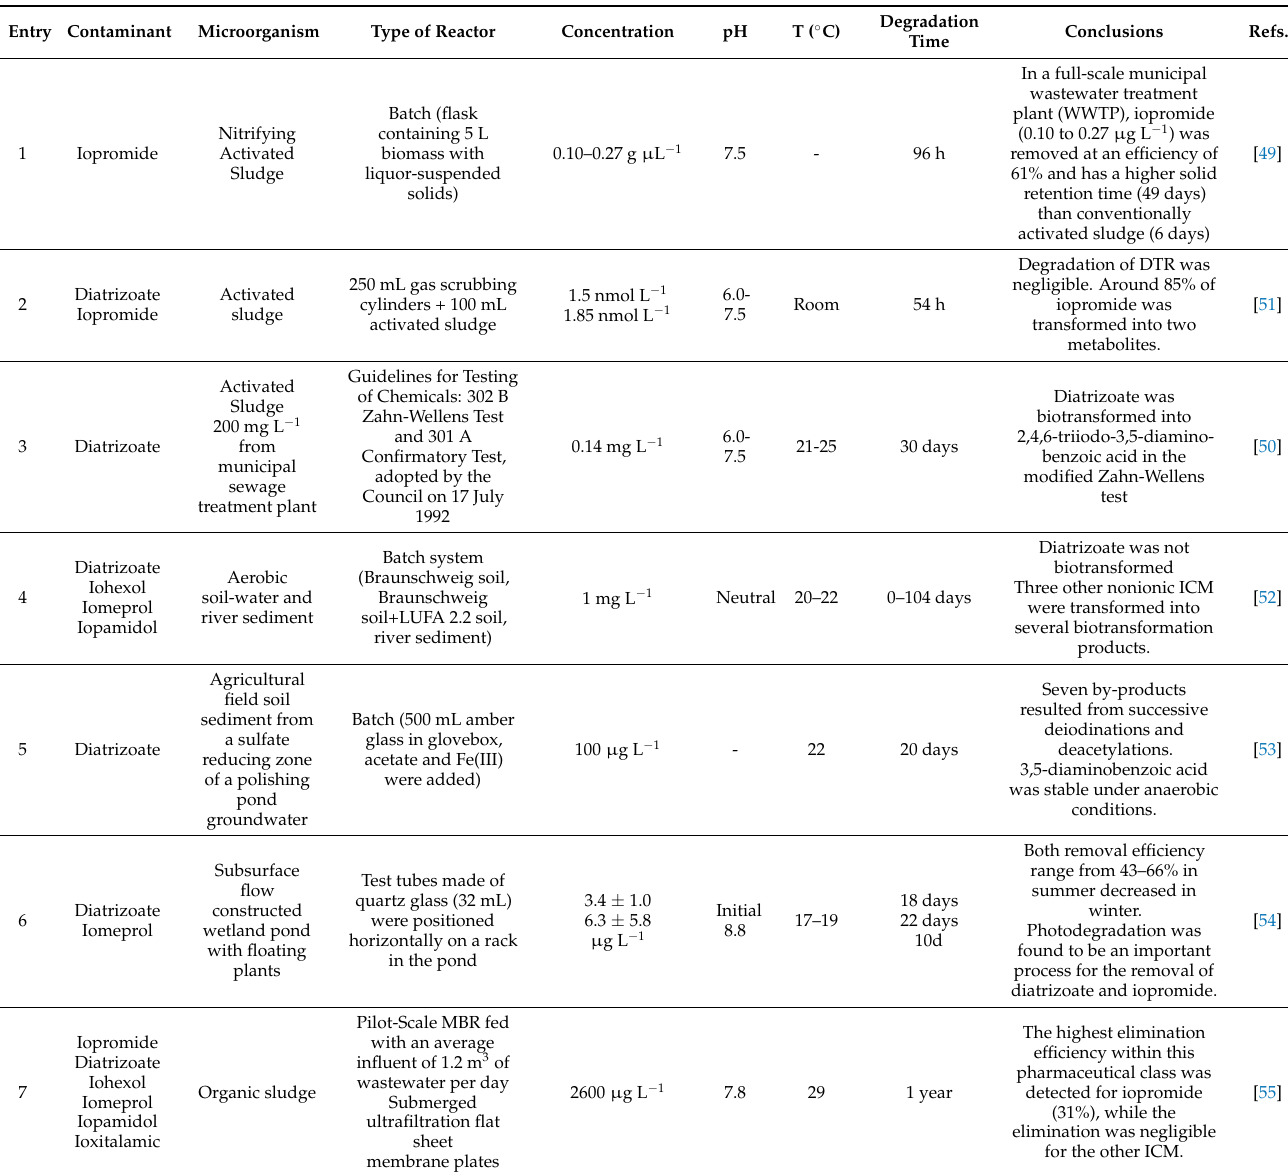
Table 2. Examples of treatment of ICM by biological